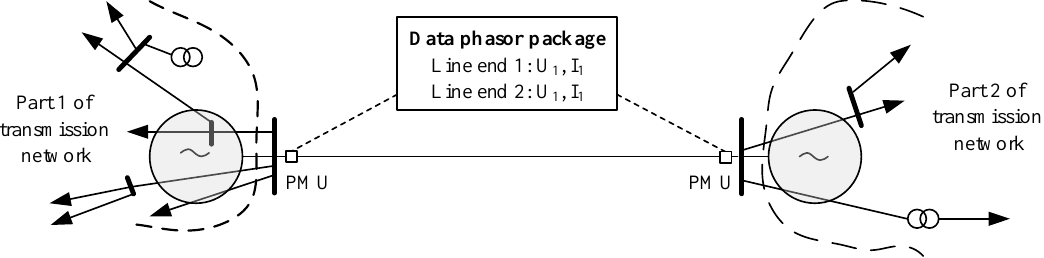
Figure 8. Simplified two machine equivalent on a transmission network line equipped with PMU devices which send phasor data packages to WAMPAC system.